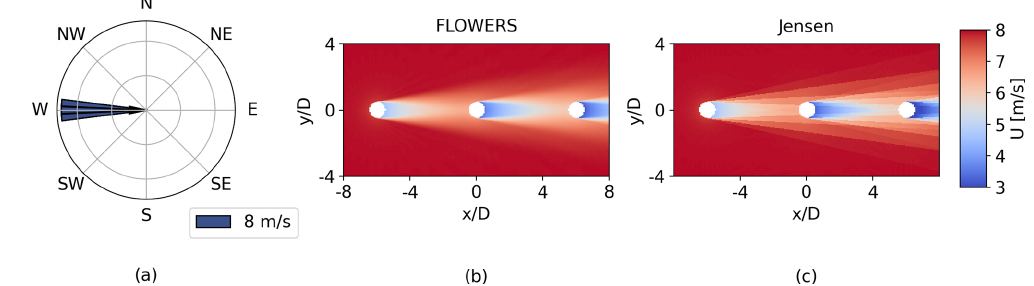
Figure 3. Annually averaged flow field comparison for three turbines aligned with the predominant wind direction with 6 D spacing. The free-stream wind speed is a constant 8ms − 1 (a) . The number of wind direction bins B used in (c) is B = 72, and the number of Fourier coefficients used to plot results in (b) is N = 37.